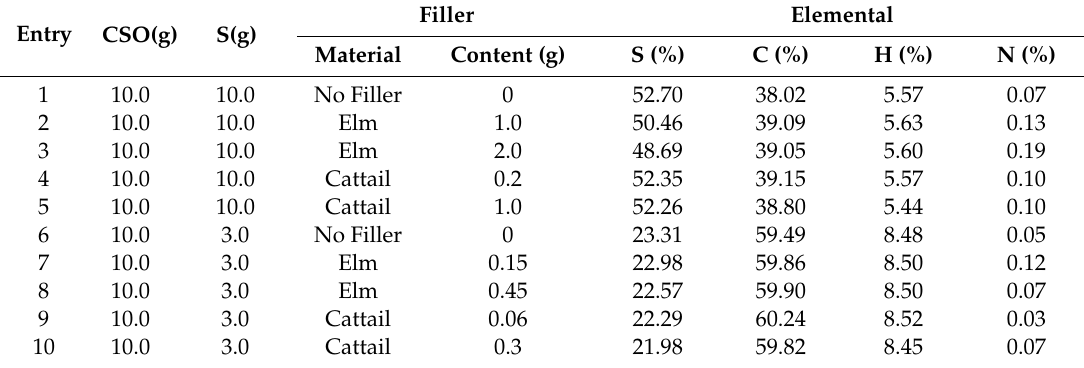
Table 3. Elemental analysis of bio-based polysulfide